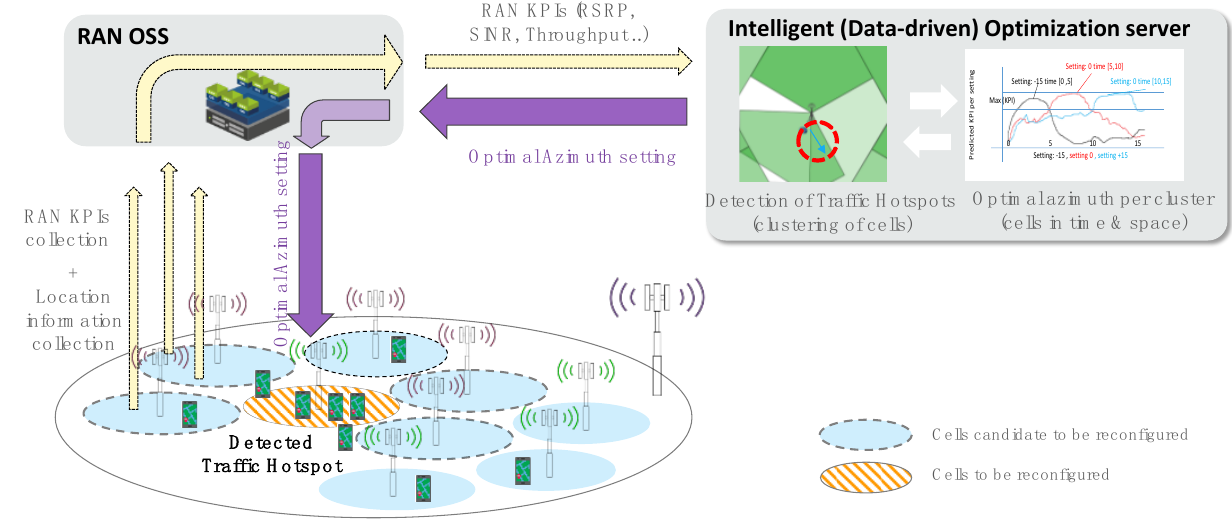
Figure 2. High level concept and context of our optimal azimuth steering solution.